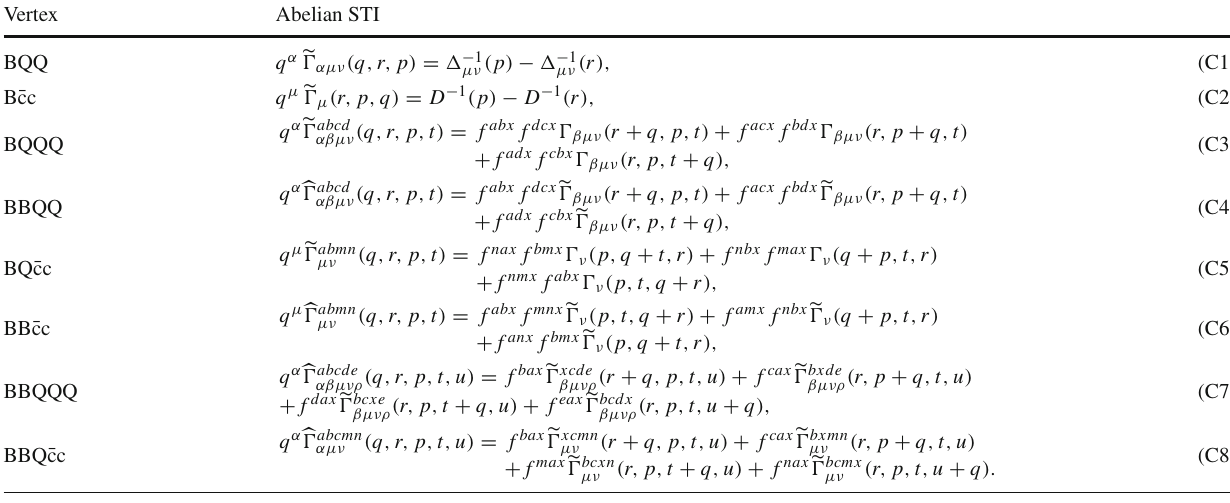
Table 2 The Abelian STIs satisfied by the BQQ, B ¯ cc, BQQQ, BBQQ, BQ ¯ cc, BB ¯ cc, BBQQQ and BBQ ¯ cc vertices Vertex Abelian